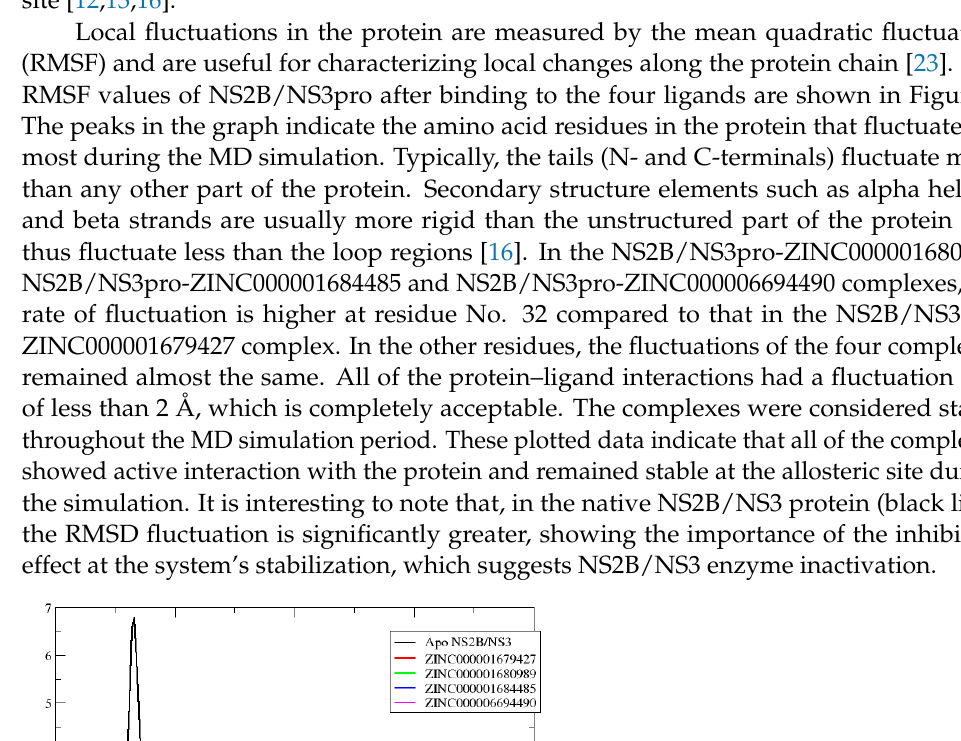
Figure 5. Radius of gyration (Rg) of the NS2B/NS3pro ZINC000001679427 (black line), ZINC000001680989 (red line), ZINC000001684485 (green line) and ZINC000006694490 (blue line) complexes studied.